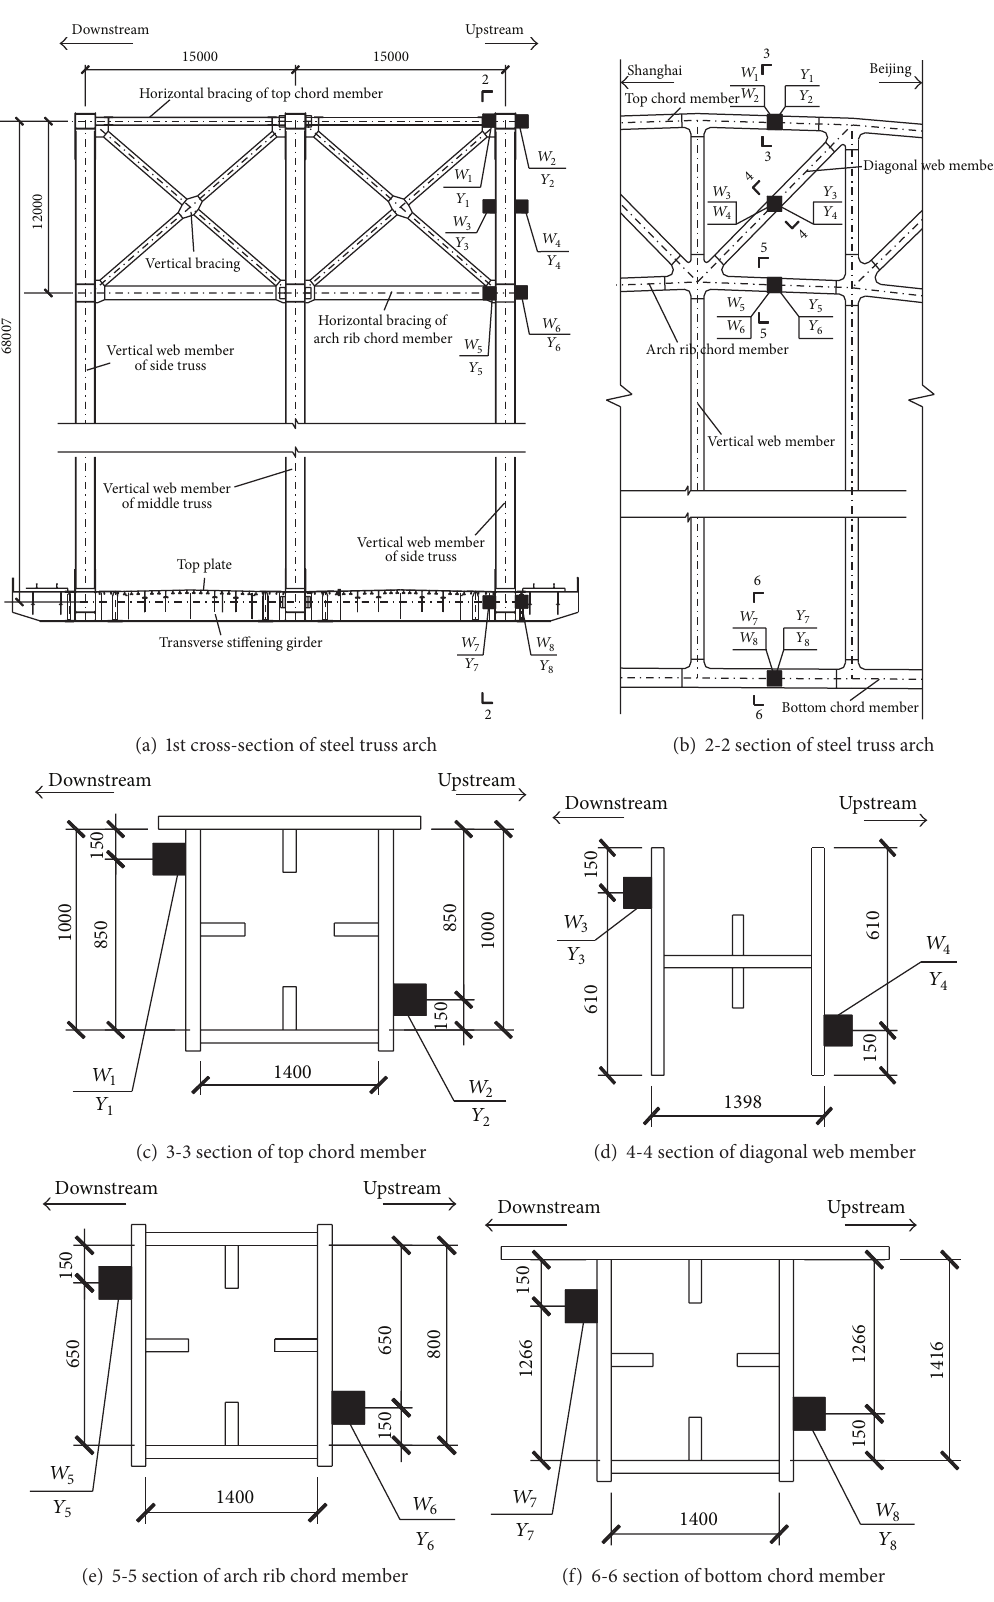
Figure 2: Layout of temperature and static strain gauges on the steel truss arch (unit: